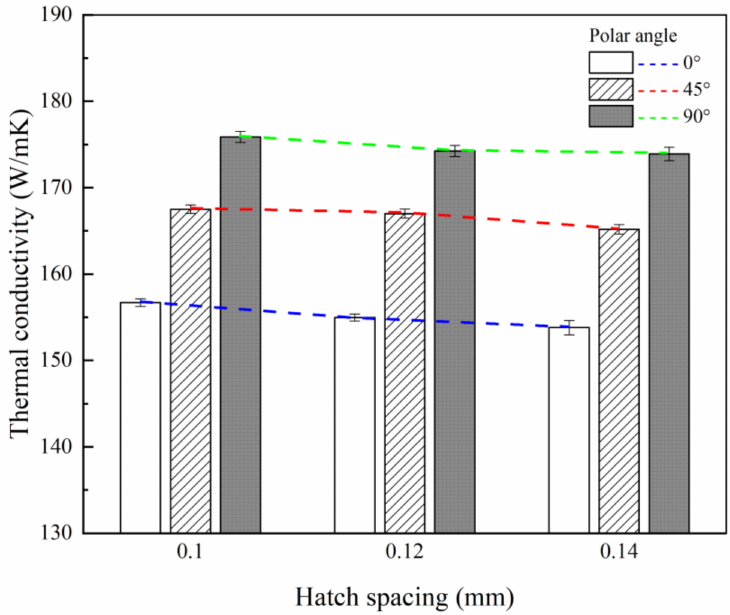
Figure 8. A comparison of thermal conductivity as a function of the hatch spacing at a test tempera- ture of 25